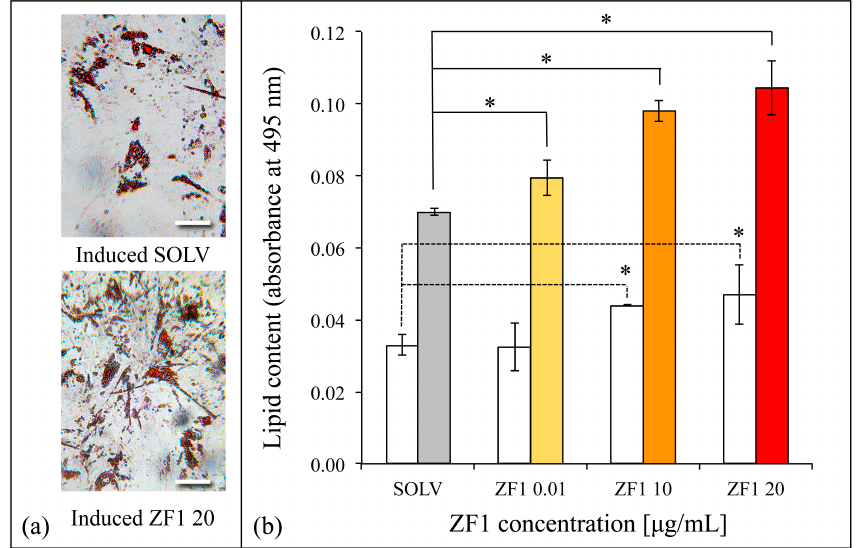
Figure 6. Effects of ZF1 treatment on adipogenic differentiation in hASCs at different concentrations. The hASCs (culture passages 5 th –7 th ) were seeded in 24-well plates and were cultured in the presence of 0.01, 10, and 20 μ g/mL ZF1, or solvent (SOLV) as a control for 72 h. ( a ) Images represent hASCs Oil red O staining after treatment with solvent ( above ) or ZF1 20 μ g/mL ( below ) and adipogenic medium. Cells positive for adipogenesis showed red colored vacuoles in cytoplasm. Scale bar corresponds to 100 μ m; ( b ) White histograms represent data derived from hASCs cultured in basal medium, while colored histograms represent those from hASCs treated with adipogenic medium. The lipid-rich vacuoles Oil Red O dye was extracted by wells and its absorbance was read at 495 nm with a spectrophotometer. Data are expressed as mean of lipid content at 495 nm absorbance ± SD. Horizontal dashed or continuous black lines represent the significance of differences between data obtained from hASCs cultured in basal and from an adipogenic medium, respectively (statistical significance was calculated using the Student’s t -test, * p < 0.05, n = 3).